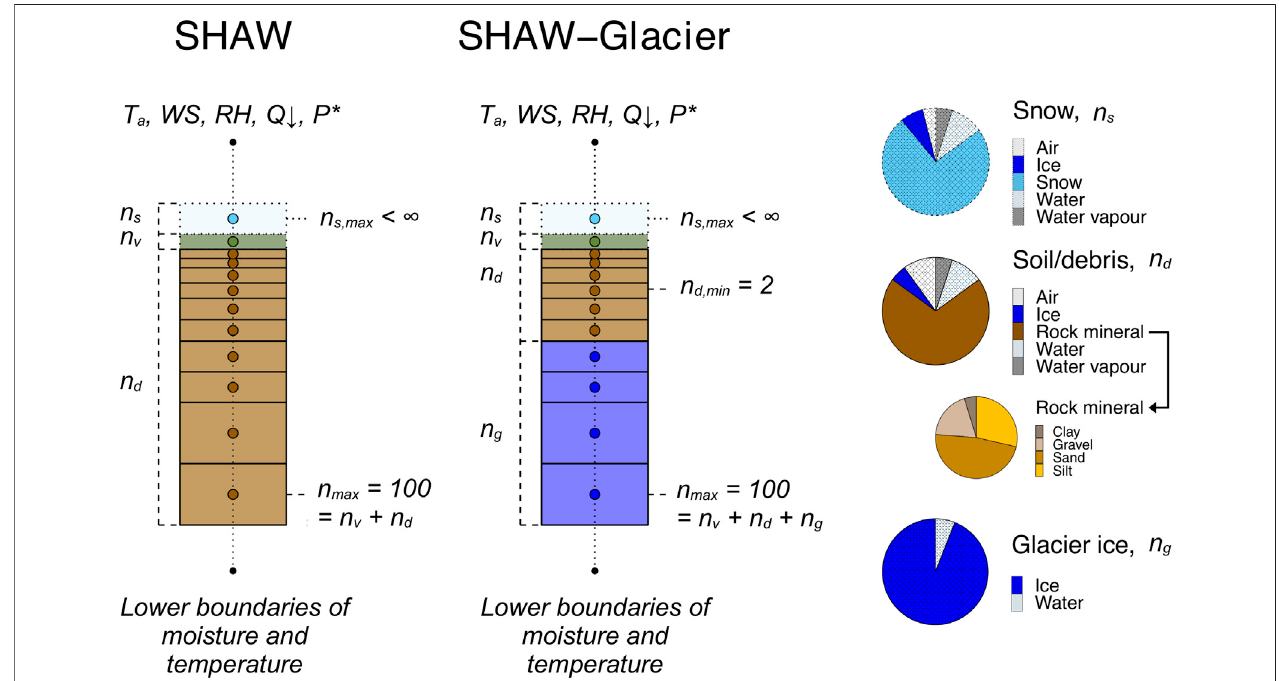
FIGURE 1 | A schematic of the simulation domain and process representations in SHAW and SHAW-Glacier. Labels n s , n v , n d and n g are the number of snow, vegetation, debris and glacier ice layers, respectively. Vegetation layers are included under SHAW-Glacier to indicate the model ’ s functionality, but are not used in this study and therefore, are not included in the detail. Dotted lines in the stacks indicate layers that are time dependent while solid lines represent layers that are constant within a model run. The pie charts show the constituents of the layers; stippling indicates constituents that are time dependent while solid areas are constant. The portions allocated to each constituent in the schematic are for example